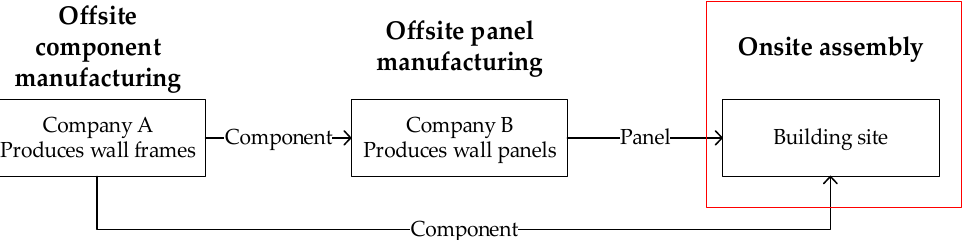
Figure 5. Relationship between component and panel manufacturing.